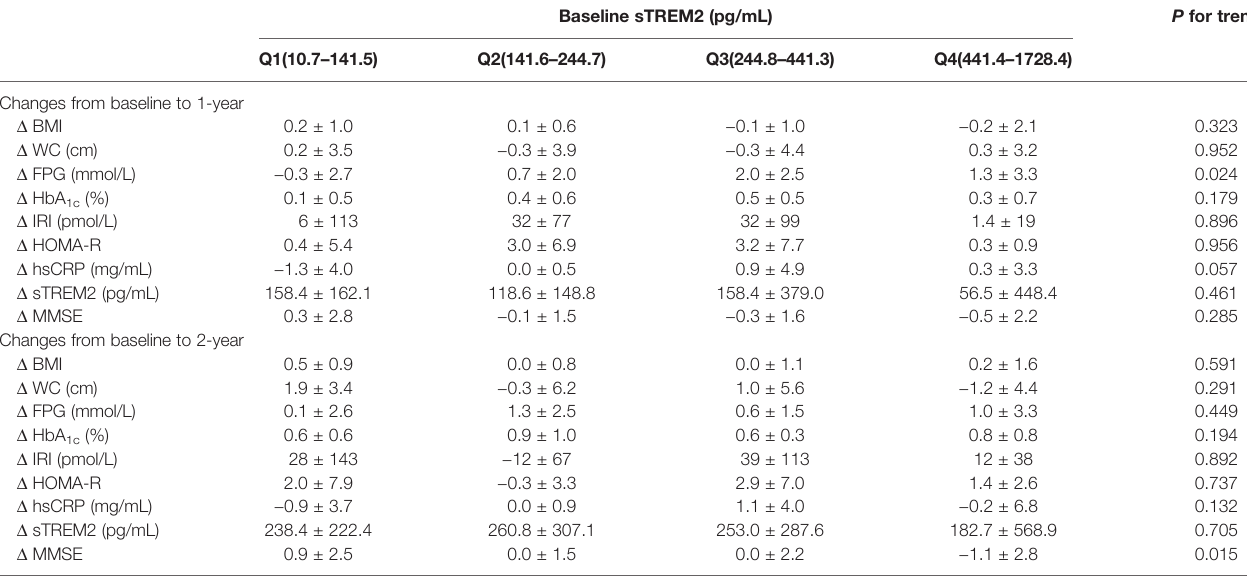
TABLE 2 | Relationships between sTREM2 levels at baseline and changes in parameters at 1 and 2 years of follow-up in HbA 1c -elevated